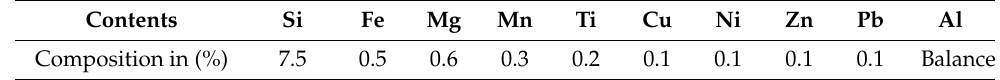
Table 1. Chemical composition of LM25 alloy.